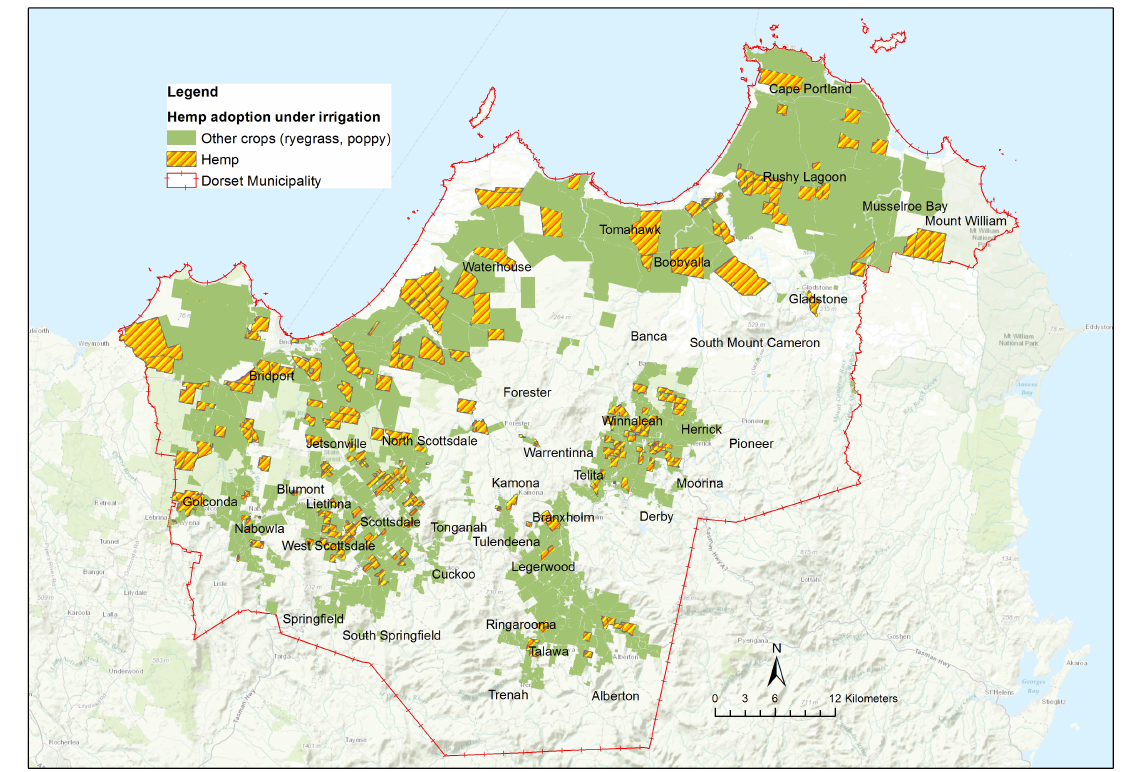
Figure 8. Distribution of hemp crops after 10 years for the Dorset region for the default scenario as irrigation infrastructure became available.